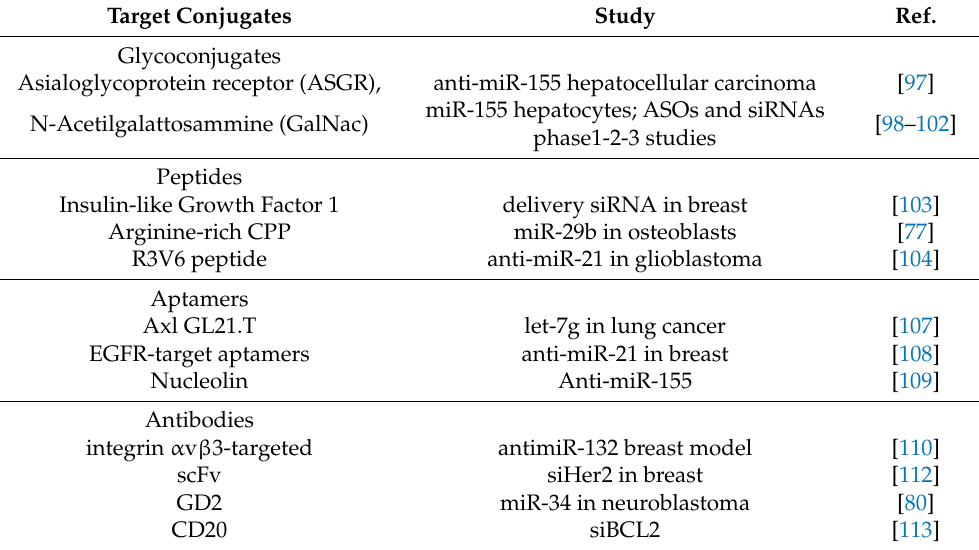
Table 3. Scheme of targeted conjugates for targeted